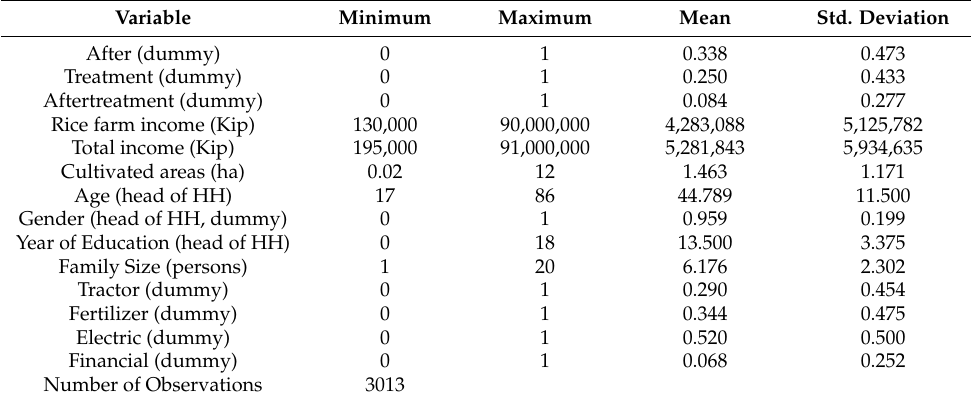
Table 2. Descriptive statistics of the variables used in the DID regression